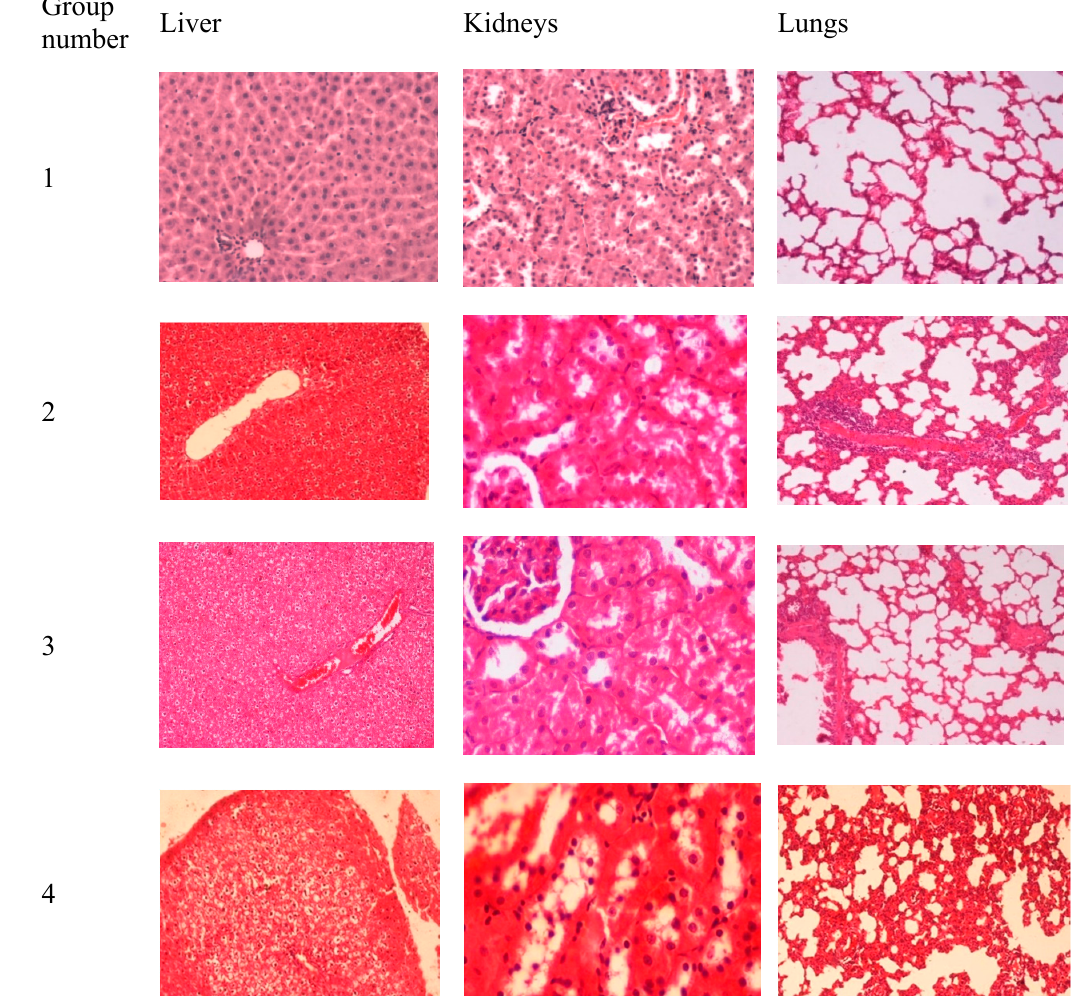
Figure 6. The results of histopathological examination of the liver, lungs, and kidneys harvested from rats receiving intratracheal: saline (group 1 ), alginate raw powder (group 2 ), chitosan raw powder (group 3 ), and alginate-chitosan carrier (group 4 ). All of the tissue slides were magnified at 200×.